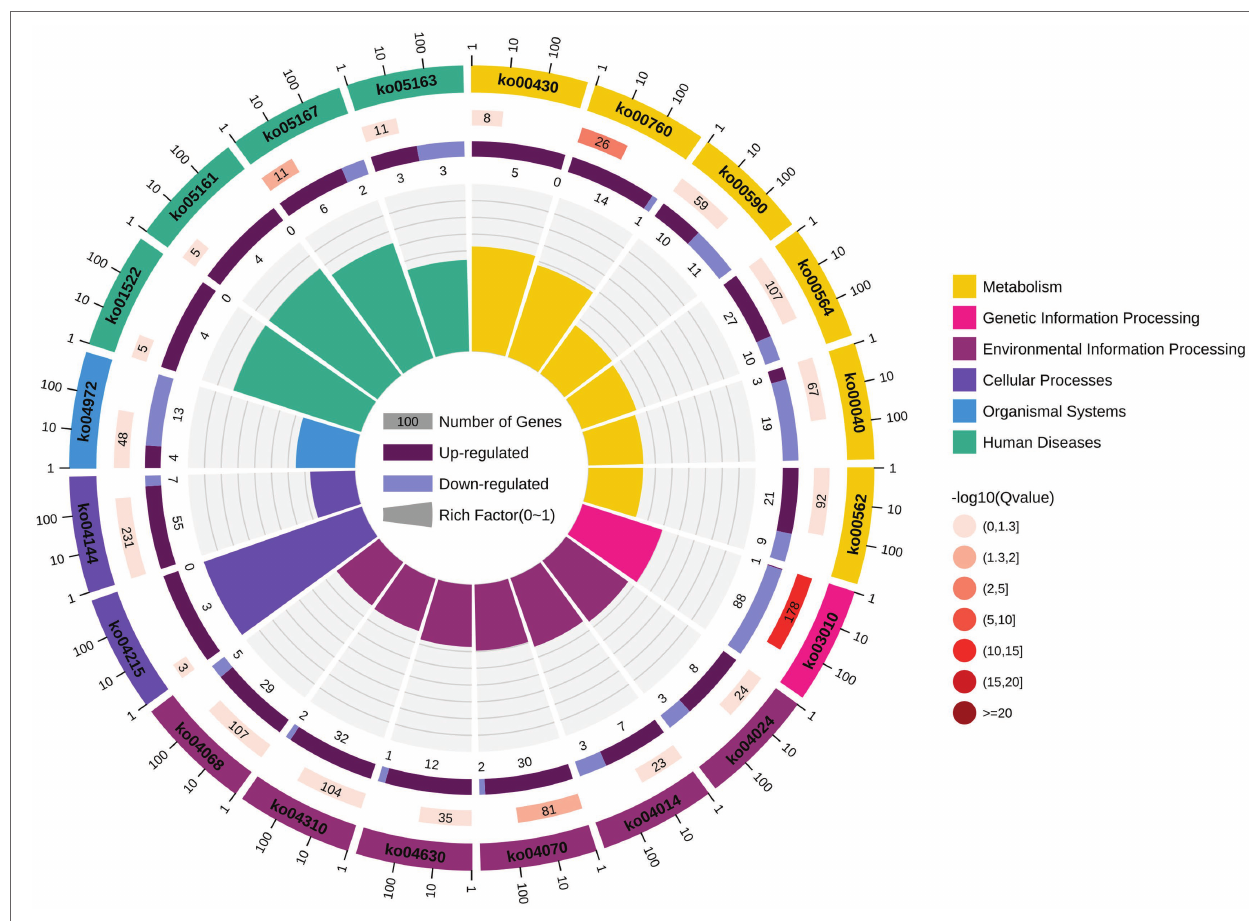
FIGURE 7 | Top 20 pathways of KEGG enrichment analysis. The first lap from outside to inside indicates the top 20 pathways of enrichments, with the coordinate scale of gene numbers outside. The second lap indicates the numbers of the genes in background and p values for each pathway. The more genes, the longer the bar. The smaller the p value, the darker the colour. The third lap indicates the ratio of the upregulated genes (deep purple) and downregulated genes (light purple), with the numbers inside of the bars. The fourth lap indicates the enrichment factor (the ratios of DEGs in background genes) of each pathway. Each cell of background auxiliary line represents 0.1. Different colours in the first and fourth laps represent different classifications of the pathways.